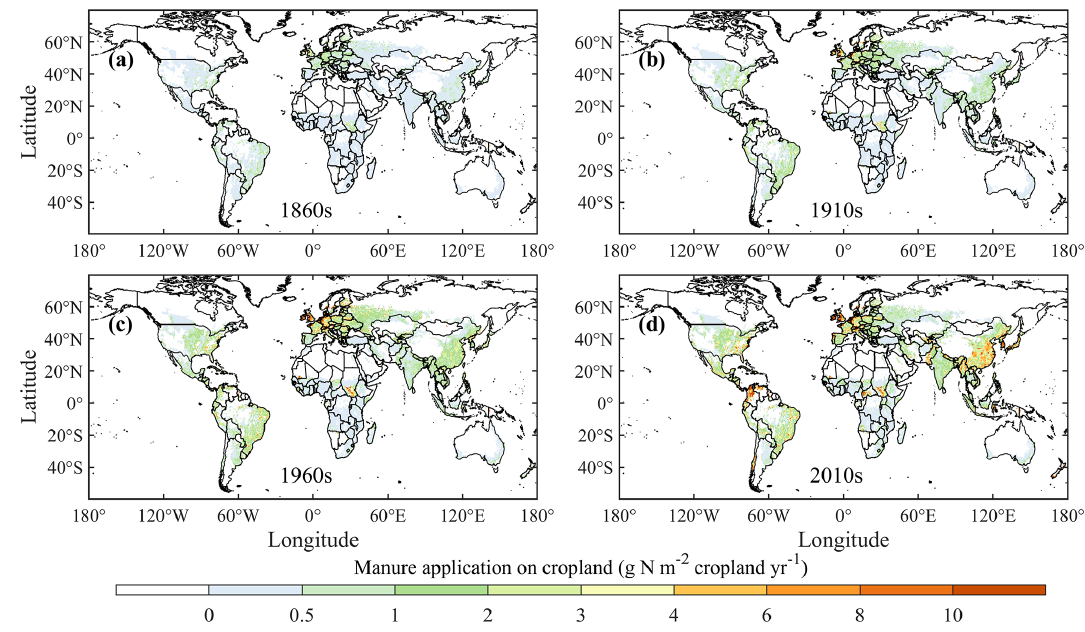
Figure 8. Spatial patterns of manure N application on cropland in the 1860s, 1910s, 1960s, and 2010s.